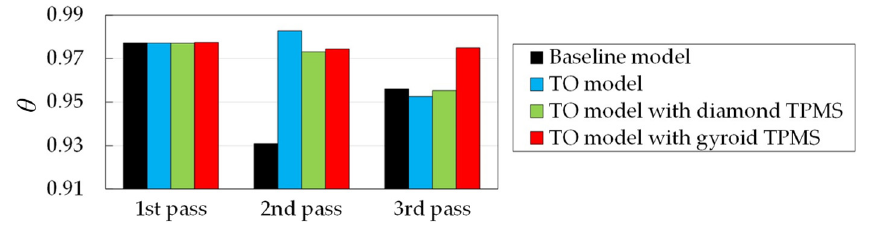
Figure 19. Temperature uniformity on the surface for all serpentine models at Re = 10,000.